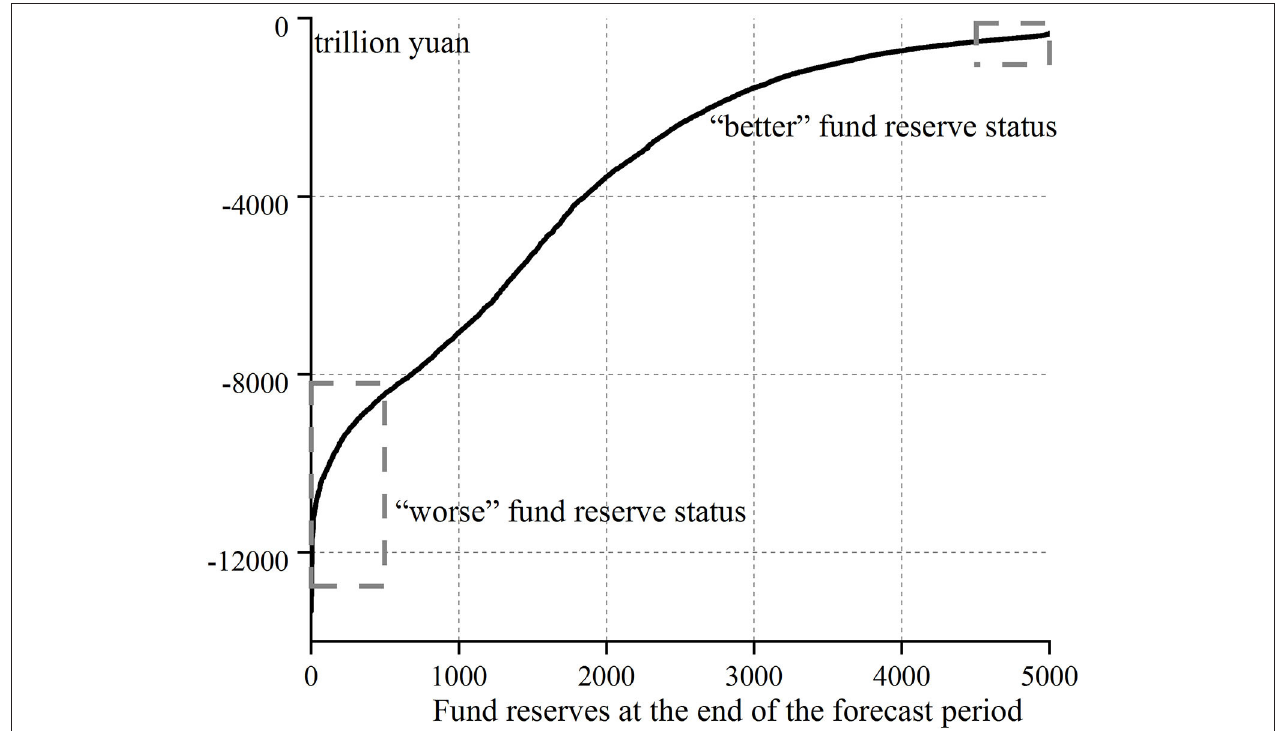
FIGURE 6 | Schematic diagram of the meaning of “better”and “worse” fund reserve status.